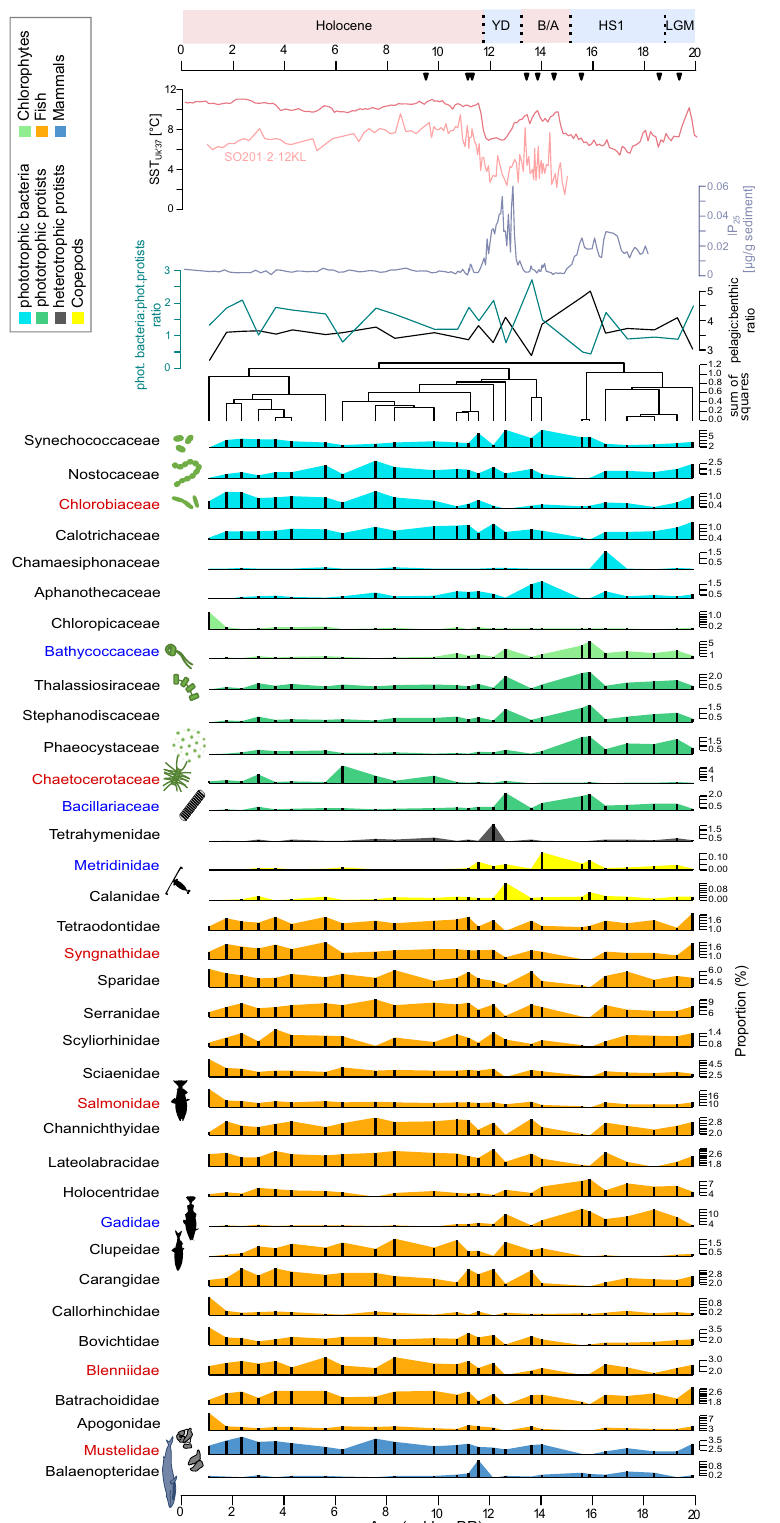
Fig. 2 | Pelagicfamiliesin the sed aDNA record ofcore SO201-2-12. Onlyfamilies representedinatleastthreesamplesandbyatleast1.5%proportionofreadcounts after resampling are shown. The dendrogram (based on constrained hierarchical clustering) and IP 25 concentrations from the same core 98 and sea-surface tem- perature (SST Uk ’ 37 ) reconstructions of the Northwest Paci fi c 52 (light red) and Northeast Paci fi c 97 (dark red) are added for comparison. Families which are sig- ni fi cant, and positively correlated with IP 25 or SST Uk ’ 37 are highlighted in blue or